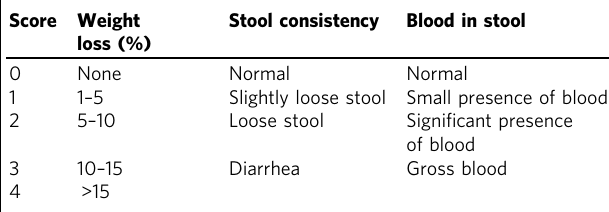
Table 1 Disease activity index (DAI) parameters and their associated scoring schemes.